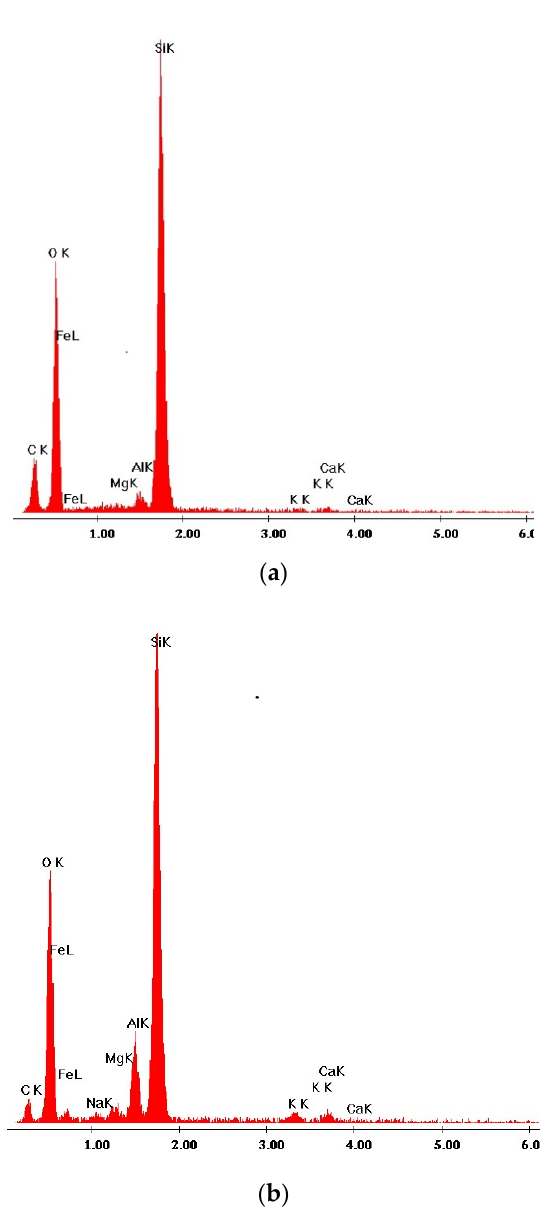
Figure 8. EDX microanalysis at points 1 ( a ) and 2 ( b ) on the surface of the old brick shown in Figure 7c.